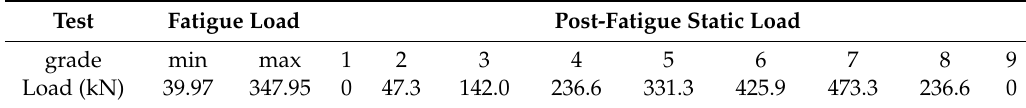
Figure 7. Schematic of monorail vehicle load (unit: mm). Table 4. Test loading value.